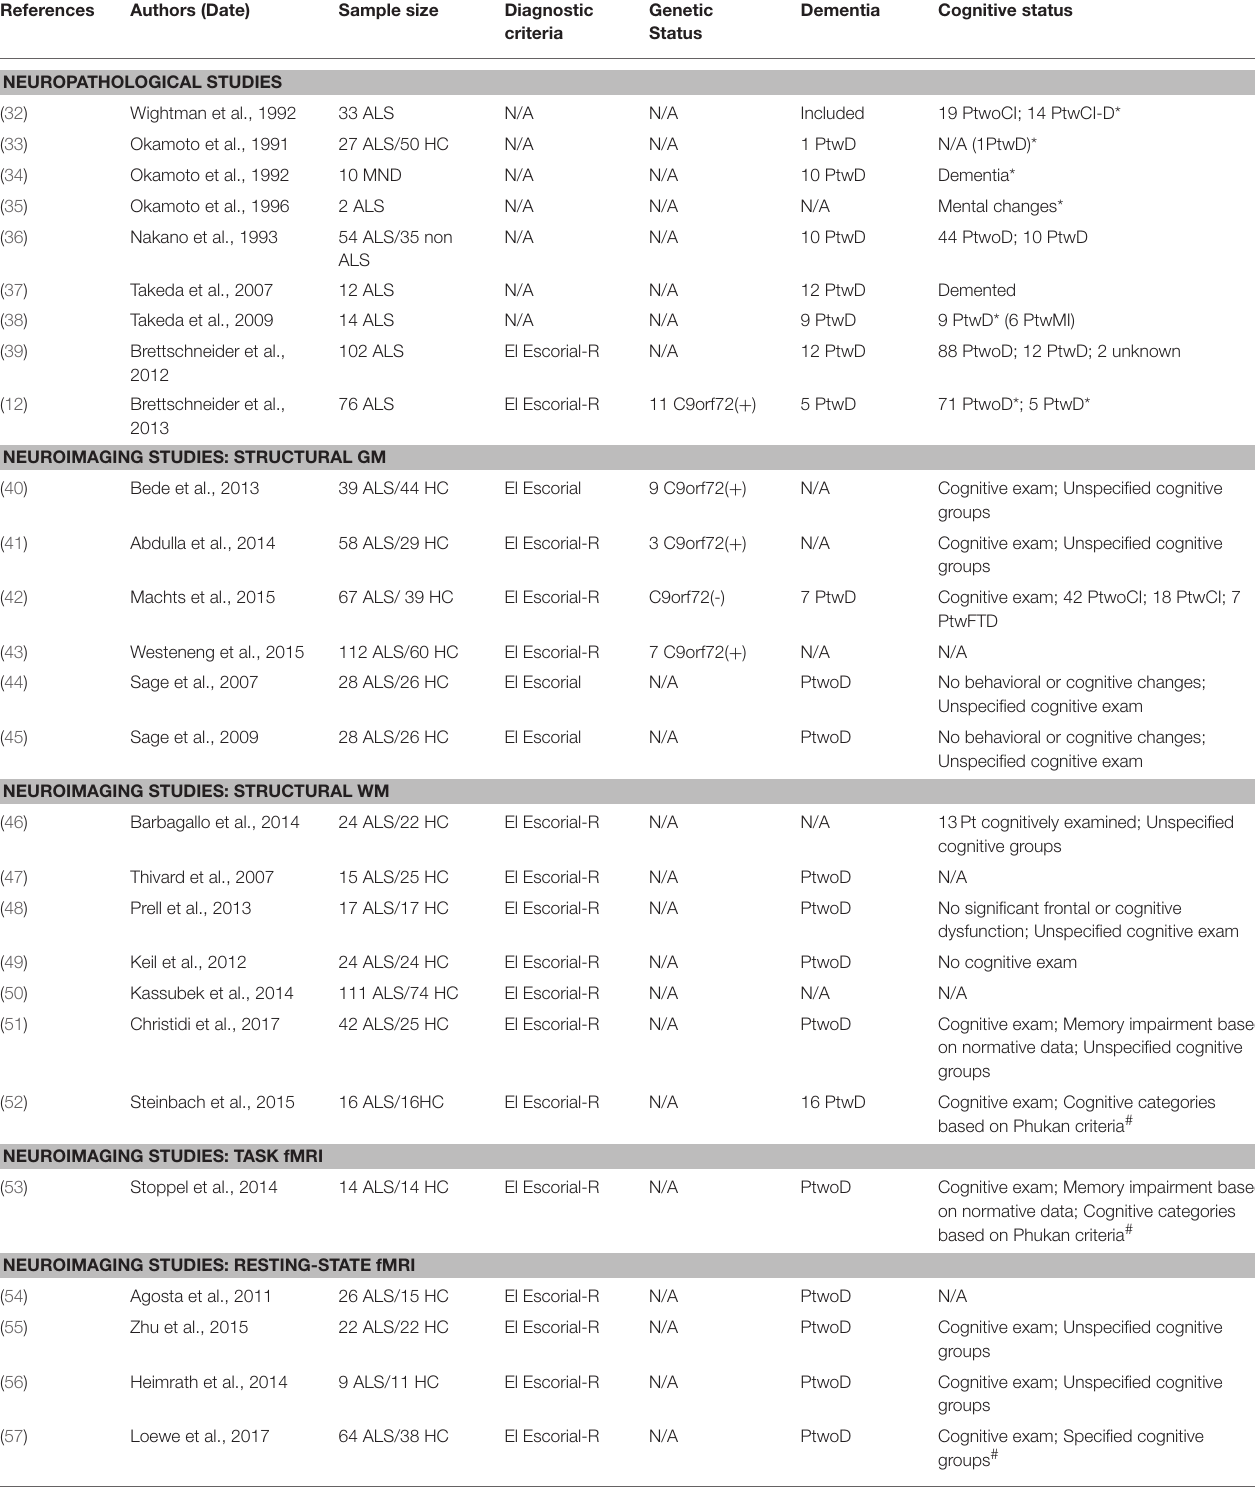
TABLE 1 | Research studies with hippocampal-related neuropathological, neuroimaging, or neuropsychological findings in ALS included in the present